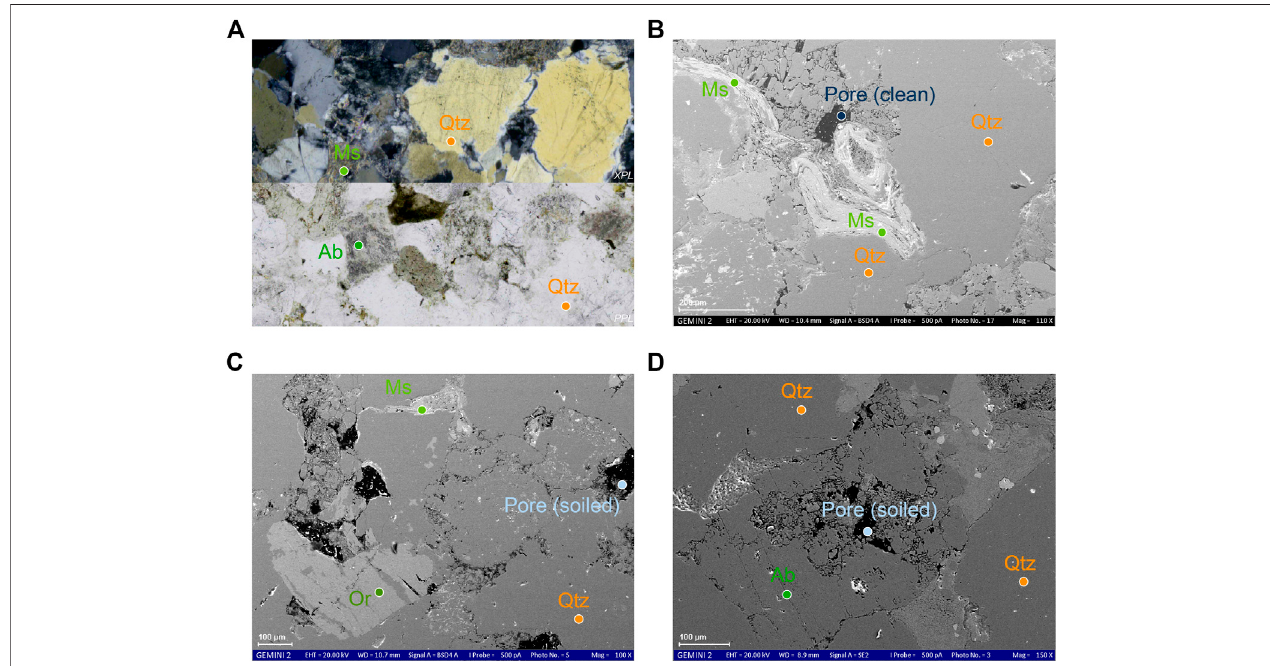
FIGURE 1 | (A) Thin section of Ruhr sandstone shown in the upper half in crossed polars (XPL) and in the lower half in plane light (PPL). SEM images of Ruhr sandstone showing (B) broken quartz grains, (C) soiled pore space, and resulting (D) microporosities due to the sericitization process in feldspars. The abbreviations of the rock-forming minerals like Qtz (quartz), Ms (muskovite), Ab (albite), and Or (orthoclase) are used according to Kretz (1983).